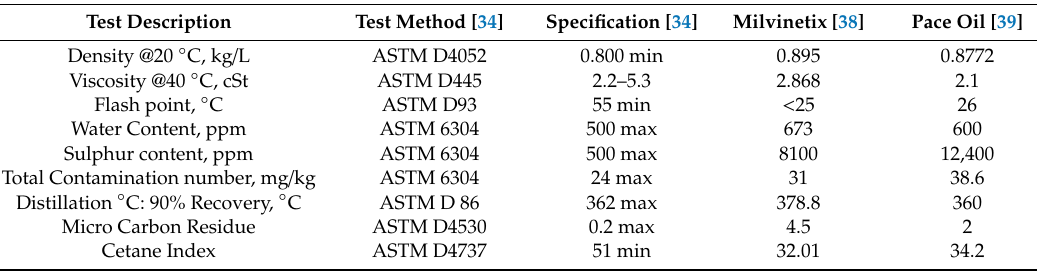
Table 1. Pyrolysis oil specifications.